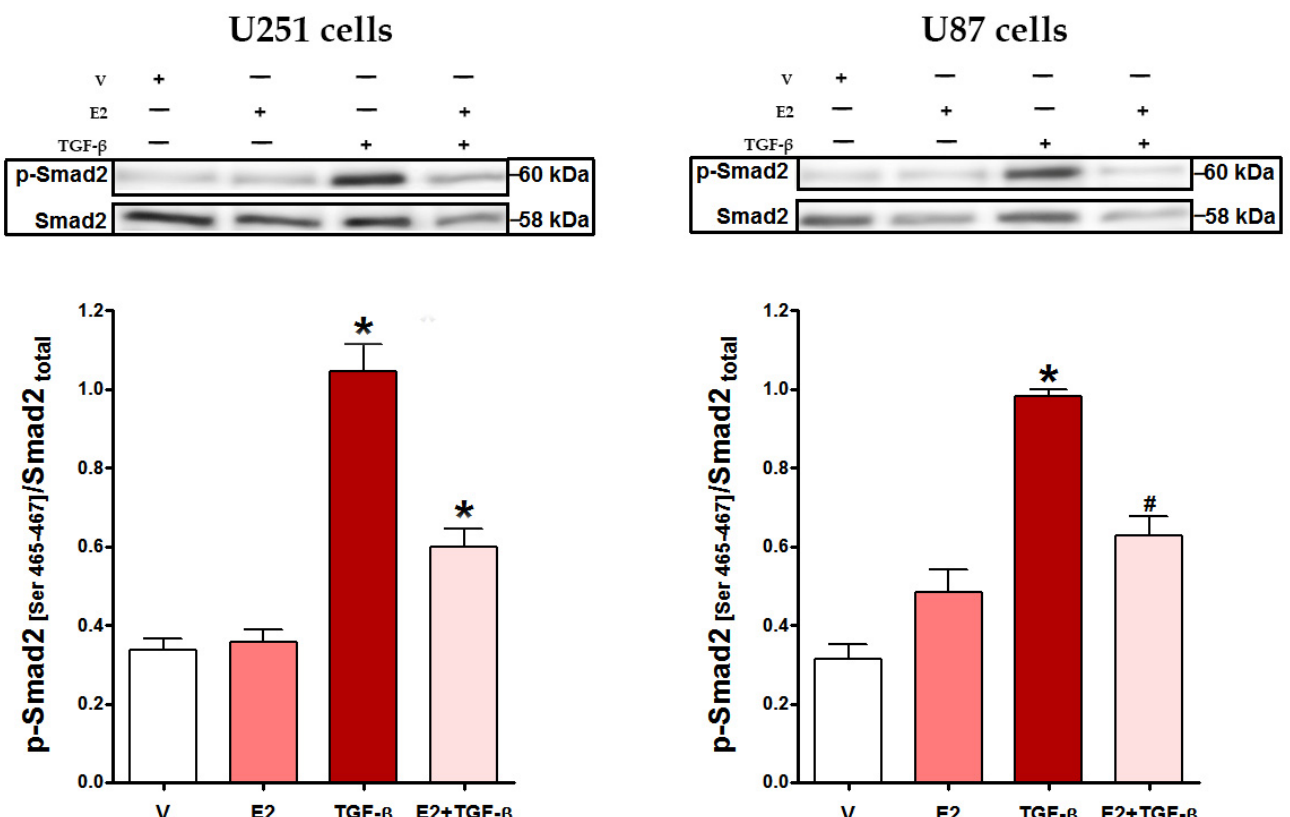
Figure 2. E2 effect on TGF- β -promoted Smad2 phosphorylation in human GBM-derived cells. U251 and U87 cells were treated with vehicle (V, 0.01% cyclodextrin + 0.0001% BSA), E2 (10 nM), TGF- β (10 ng/mL) and E2 + TGF- β for 48 h. Smad2 phosphorylation levels at serine residues 465–467 ( p -Smad2) were determined by Western Blot. Densitometric analysis with their respective representative bands is shown. Results are expressed as the mean ± standard error of the mean (SEM); n = 3; * p < 0.05 vs. all other groups; # p < 0.05 vs. V.